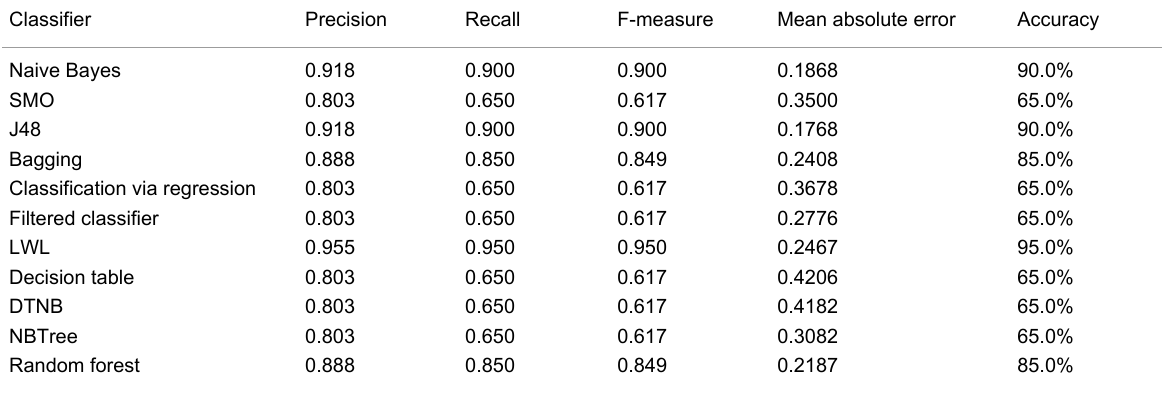
Table 6: Results from the external validation test set analysis listed by classifier including the molecular descriptors expert-selected with cytotoxicity concentration. See Equation 1–4 for the definition of precision, recall, F-measure, and mean absolute error and accuracy.